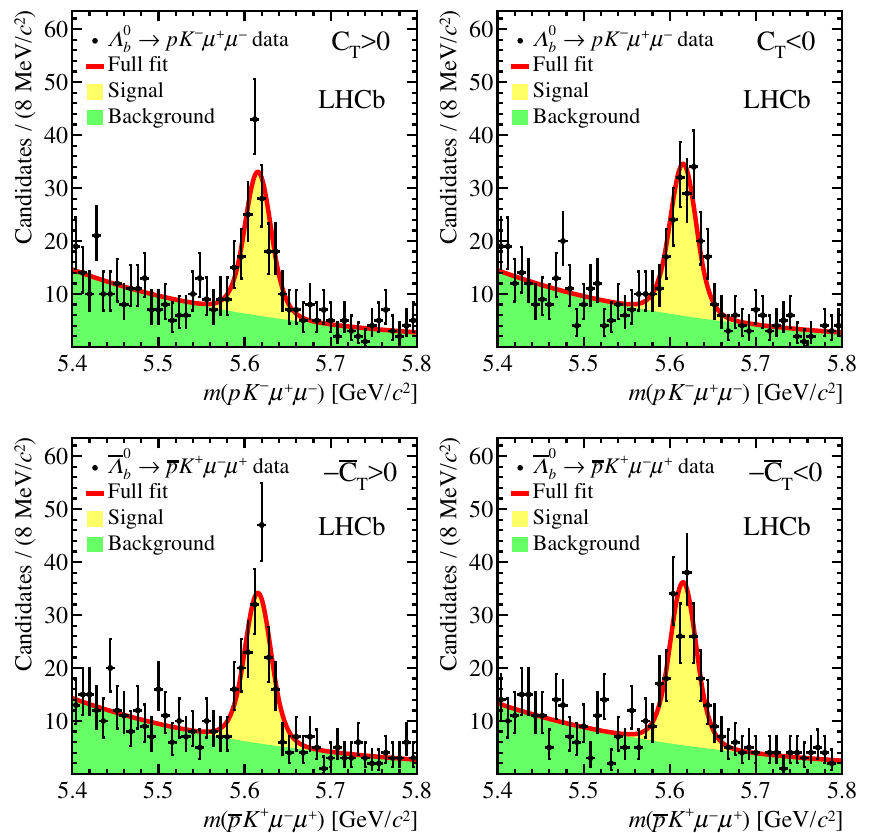
Figure 4 . Invariant mass distributions of the (cid:3) 0 A measurements. Plots refer to (top) (cid:3) 0 b T (left) C > 0 ; C > 0 and (right) C b T b T (cid:0)